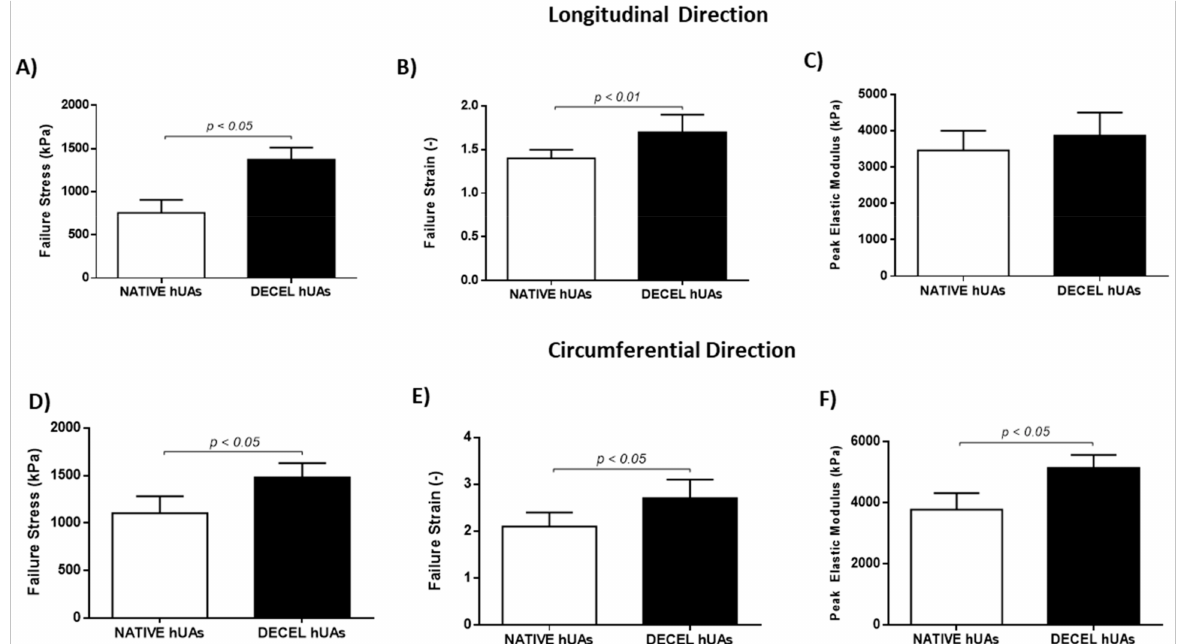
Figure 5. Biomechanical analysis of native and decellularized hUAs. Native and decellularized hUAs were tested for the maximum strain ( A , D ), failure strain ( B , E ) and peak elastic modulus ( C , F ), in the longitudinal ( A – C ) and circumferential ( D – F ) direction, respectively. Statistically significant differences between native and decellularized hUAs were found in failure stress ( p < 0.05, in both directions), peak elastic modulus ( p < 0.05, circumferential direction) and failure strain ( p < 0.01 for the longitudinal direction and p < 0.05 for the circumferential direction). DECEL: